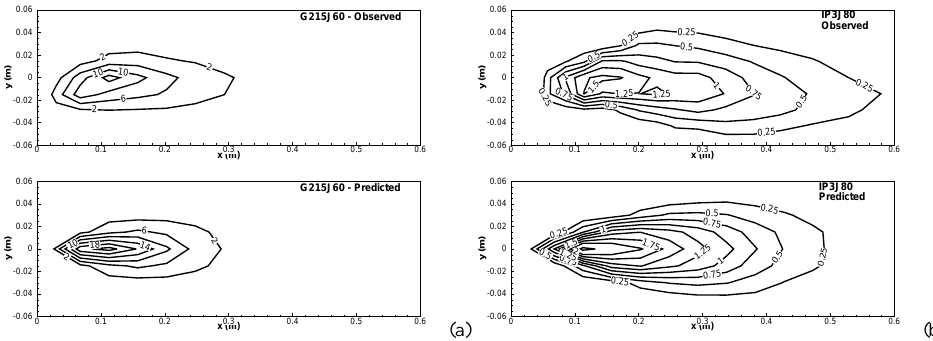
Fig. 4. 2D sediment deposition pattern for (a) glass particles 215 µ m, u 0 = 0 . 59 m/s, w s = 2 . 65 cm/s, (b) plastic IP3 particles 716 µ m, u 0 = Figure 4. 2-D sediment deposition pattern for (a) glass particles 215µm, u 0 = 0 . 59ms − 1 , w s = 2 . 65cms − 1 , (b) plastic IP3 particles 0 . 79 m/s, w s = 2 . 02 cm/s. Contours in g/m 2 /s. 716µm, u 0 = 0 . 79ms − 1 , w s = 2 . 02cms − 1 . Contours in gm − 2 s − 1 .